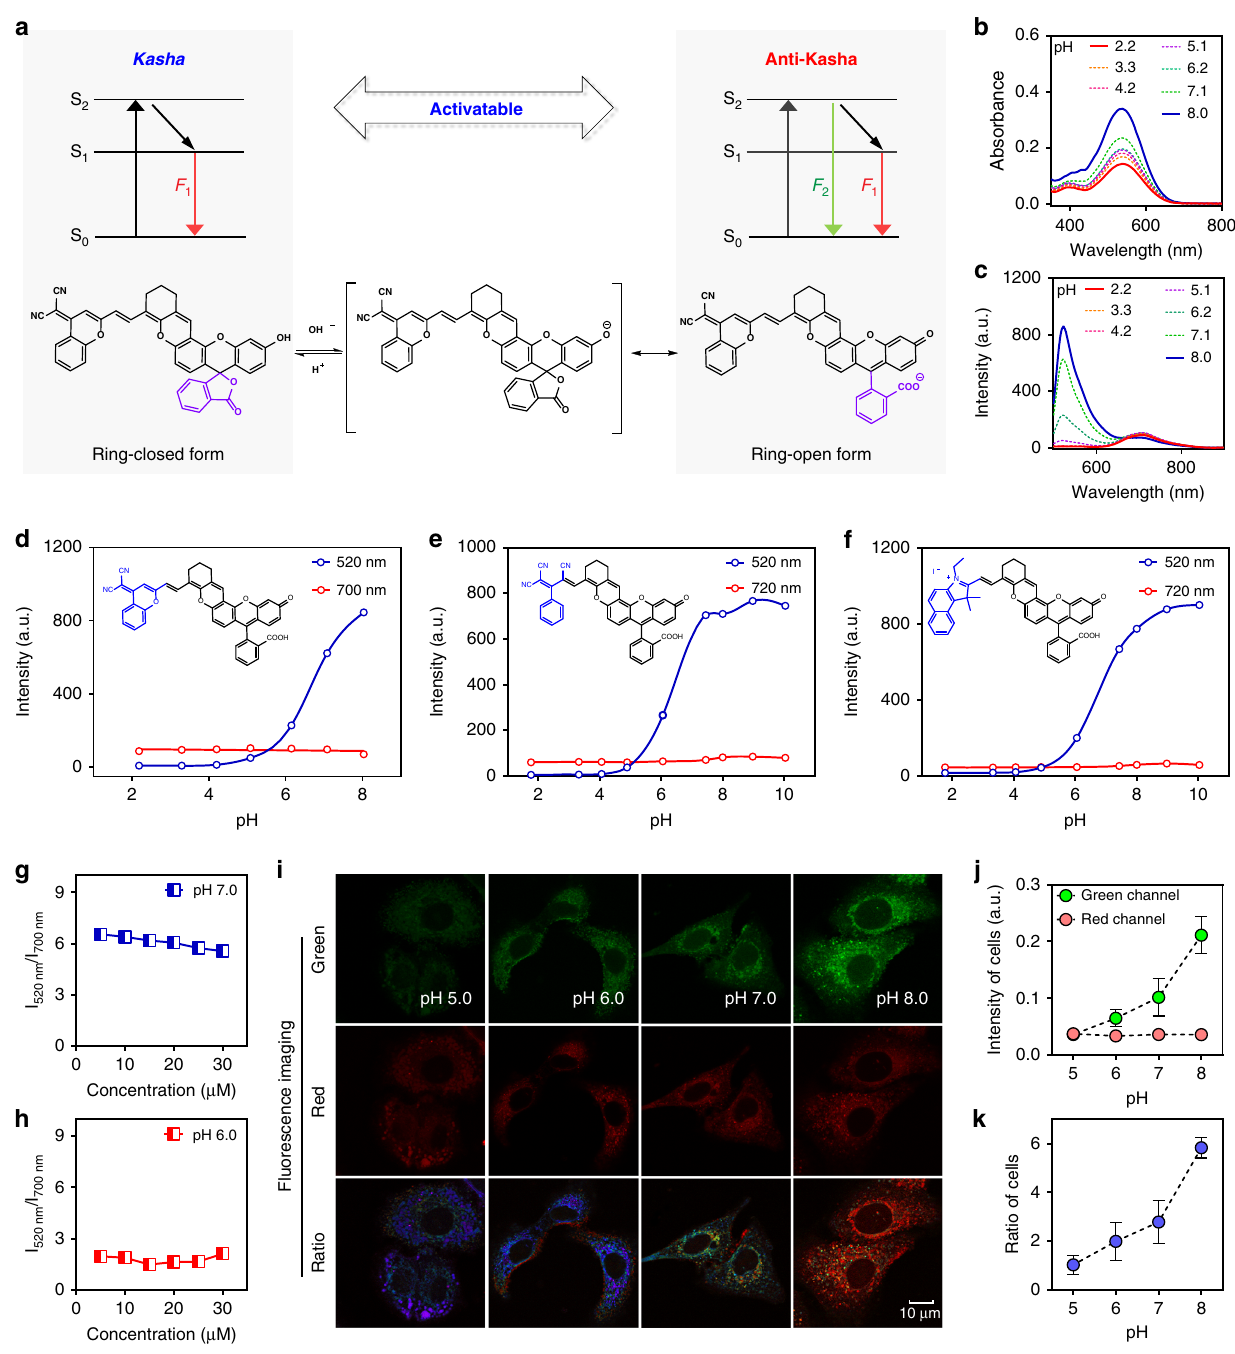
Fig. 4 Anti-Kasha/Kasha switch-induced dual-emission response with an internal intensity reference signal. a Schematic illustration of spirolactone- switch-controlled molecules for tuning anti-Kasha/Kasha properties. Absorption ( b ) and fl uorescence spectra ( c ) of DCM-IFC in the range of pH 2.2 – 8.0. Dual-emission response with the internal intensity reference signal of DCM-IFC ( d ), TCB-IFC ( e ), and BI-IFC ( f ) at different pH values, λ ex = 480 nm. Source data are provided as a Source Data fi le. Concentration-dependent emission ratios (S 2 /S 1 ) detected for DMC-IFC at pH 7.0 ( g ) and pH 6.0 ( h ). Source data are provided as a Source Data fi le. Dual-channel ratiometric imaging ( i ), fl uorescence intensity ( j ) and ratio ( k ) of DCM-IFC in A549 cells across different pH values. Data with error bars are expressed as mean ± s.d., n = 3. Source data are provided as a Source Data fi le. Note: all fl uorescence spectra were measured in a mixture solution of MeCN/Britton-Robinson